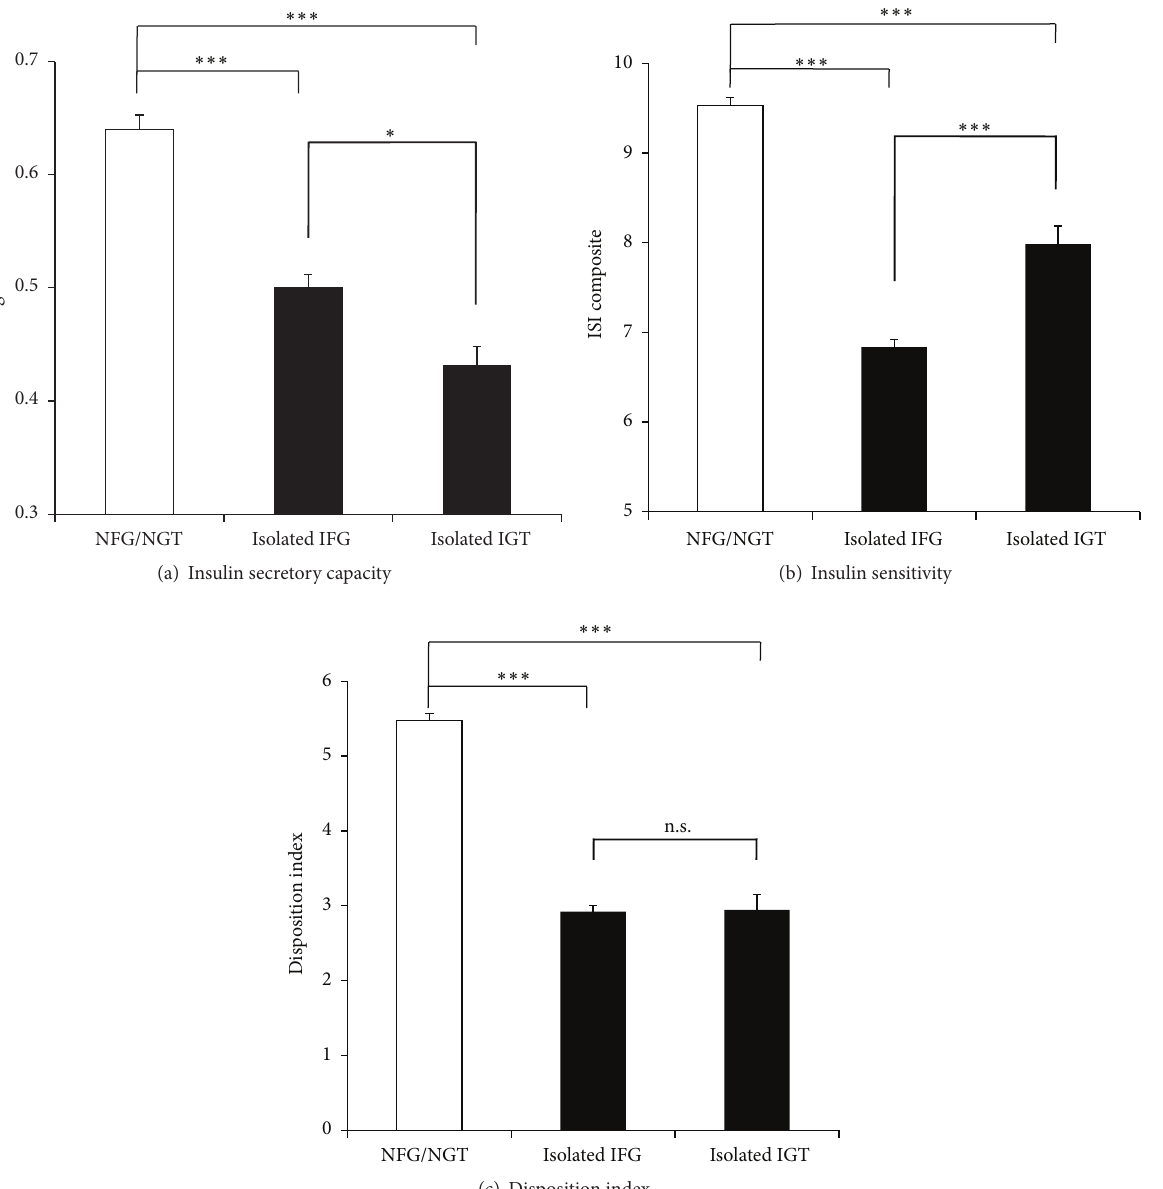
Figure 2: (a), (b), (c) Comparison of early-phase insulin secretory capacity (a), insulin sensitivity (b), and disposition index (c) among NFG/NGT, isolated IFG, and isolated IGT. Statistical significance between two groups was represented as ∗ : 𝑝 < 0.05 , ∗∗∗ : 𝑝 < 0.0001 , and n.s.: not